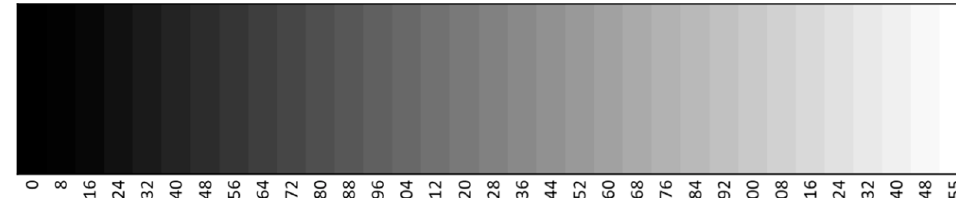
Figure 10. Grayscale tonal range from 0 to 255 [22].